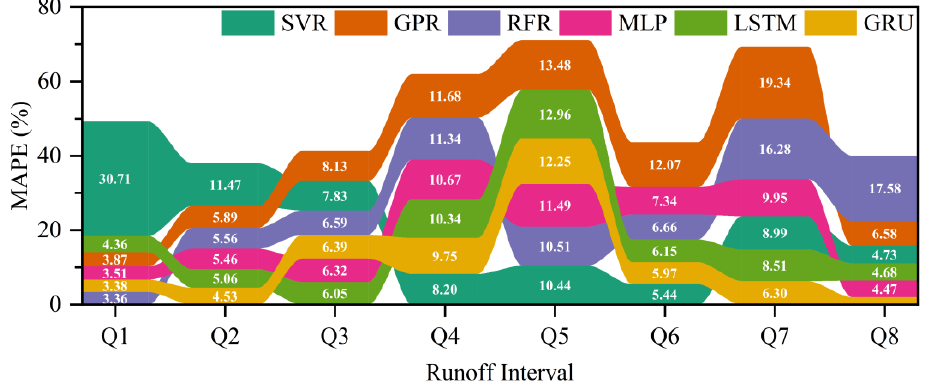
Figure 6. Ribbon diagram of the MAPEs for inflow hydrograph prediction of the TGR by the models during the testing period.